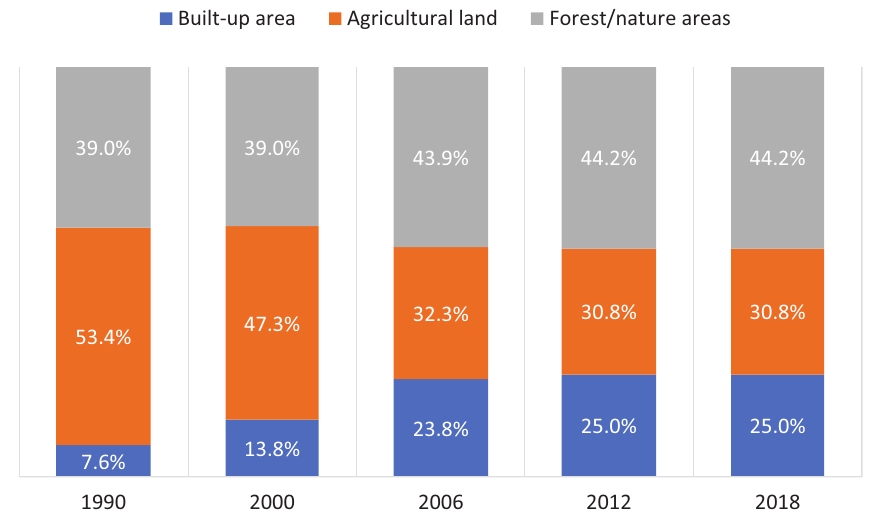
Figure 5. Rezoning. Source: Compiled by the authors based on TeIR (2021)